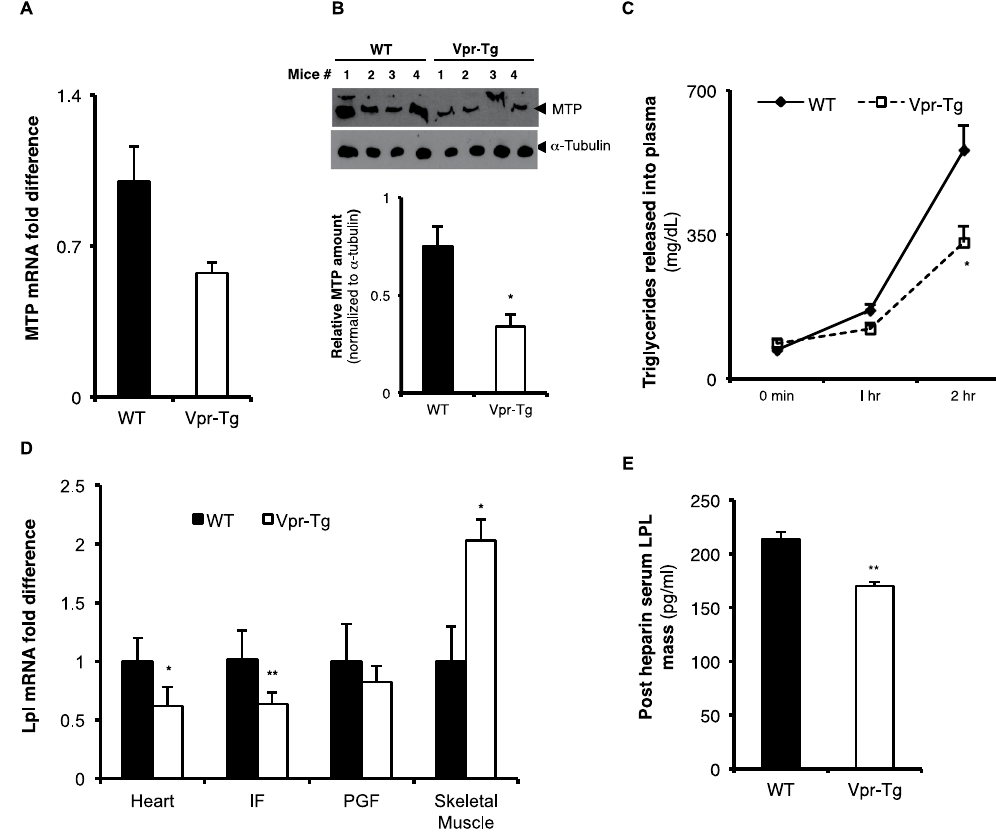
Figure 6. Altered levels of MTP and blunted VLDL-TG export in liver of Vpr-Tg mice. ( A ) There was a trend towards decreased Mttp mRNA in liver of Vpr-Tg compared to WT mice (P = 0.077, N = 5–6 per group). ( B ) Decreased protein level of MTP was present in liver of Vpr-Tg compared to WT mice (N = 4 per group). ( C ) Decreased VLDL export was observed in liver from Vpr-Tg compared to WT mice following injection of the LPL inhibitor Pluronic F-127 (N = 4 per group). ( D ) There was variably altered Lpl mRNA in heart, inguinal fat, perigonadal fat and skeletal muscle of Vpr-Tg compared to WT mice (N = 7–8 per group). ( E ) Decreased LPL mass was present in Vpr-Tg compared to WT mouse plasma following heparin injection (N = 4 per group). Values are mean ± SE. * P < 0.05, ** P < 0.01. [Note: Immunoblot figures have been cropped to show relevant bands. Original uncropped blots are shown in Supplementary Fig. S3. No image enhancement was used, but the bluish background of the original autoradiogram was changed to